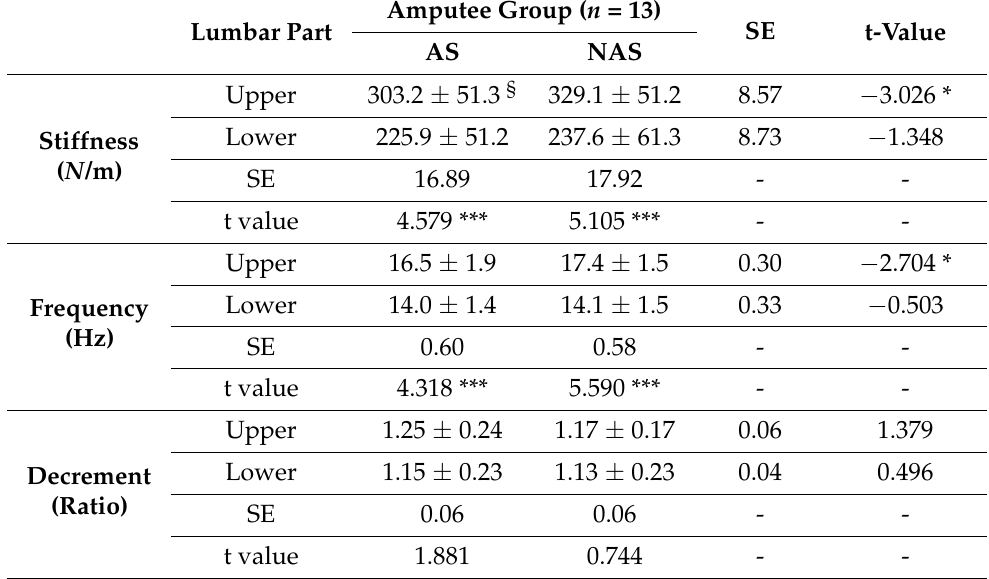
Table 2. Comparison of lumbar intramuscular properties between AS and NAS sides in the amputee